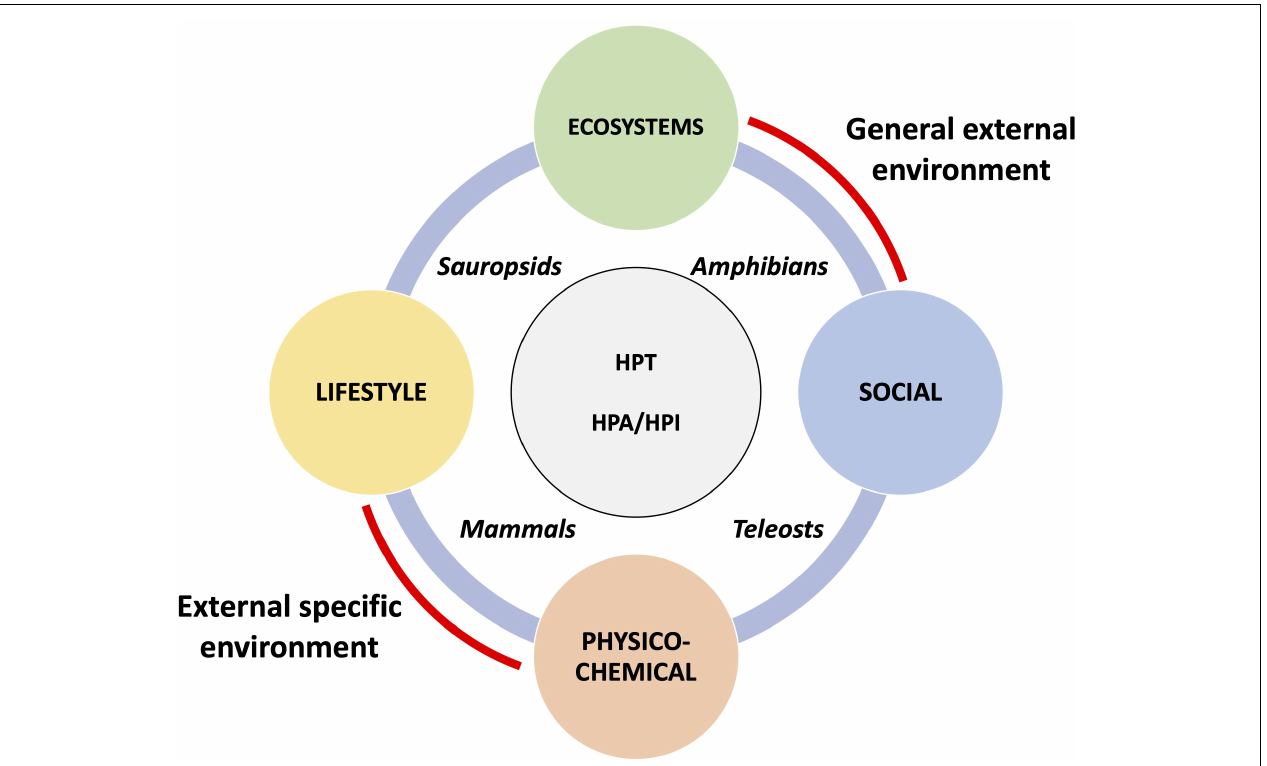
FIGURE 1 | The exposome targets the HPT and HPA/HPI axe in vertebrates. The four components of the exposome (ecosystems, lifestyle, social, and physico-chemical expositions) may affect developmental transitions in vertebrates, including teleosts, amphibians, sauropsids, and mammals, by acting in part at the level of the HPT and HPA/HPI